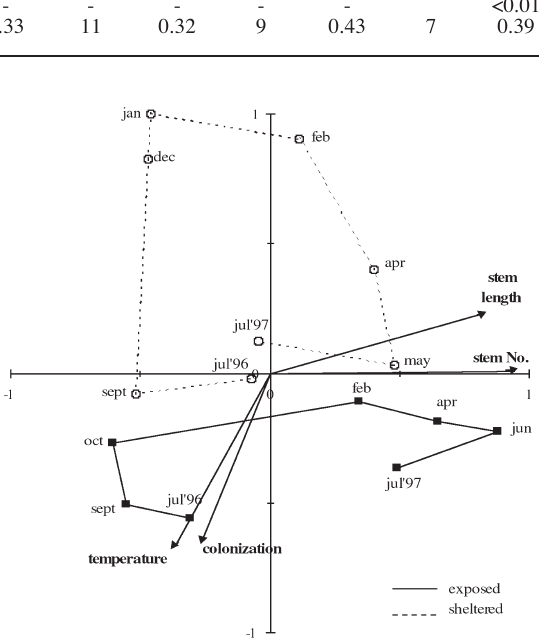
F IG . 2. – Ordination of faunal samples for exposed and sheltered sites using Analysis of Canonical Correspondence with environ- mental variables. x and y are the first two CCA axes. Arrows show direction and rates of variation among month in water temperature, % of colonised algal stems, algal stem length and number of sampled stems (P =